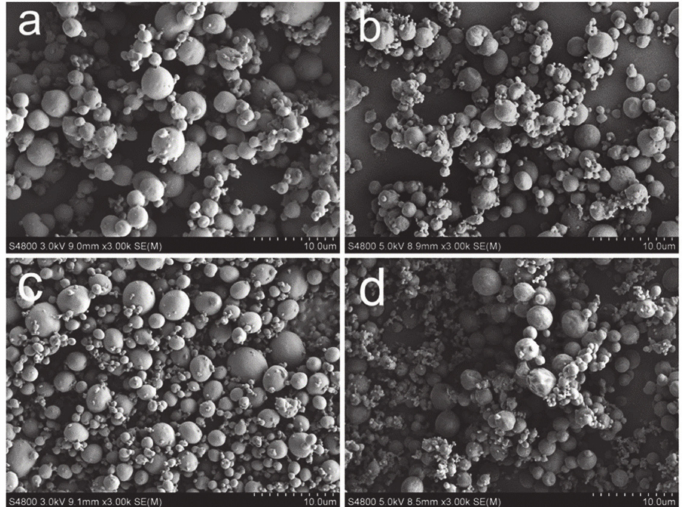
Figure 7. SEM images of microparticles prepared using the SEDS process. ( a ) FA-PEG-PLLA, ( b ) paclitaxel-loaded FA-PEG-PLLA (90% FA), ( c ) PEG-PLLA and ( d ) paclitaxel-loaded PEG-PLLA (scale 10 µ m). Reprinted with permission from [101], Springer Nature,